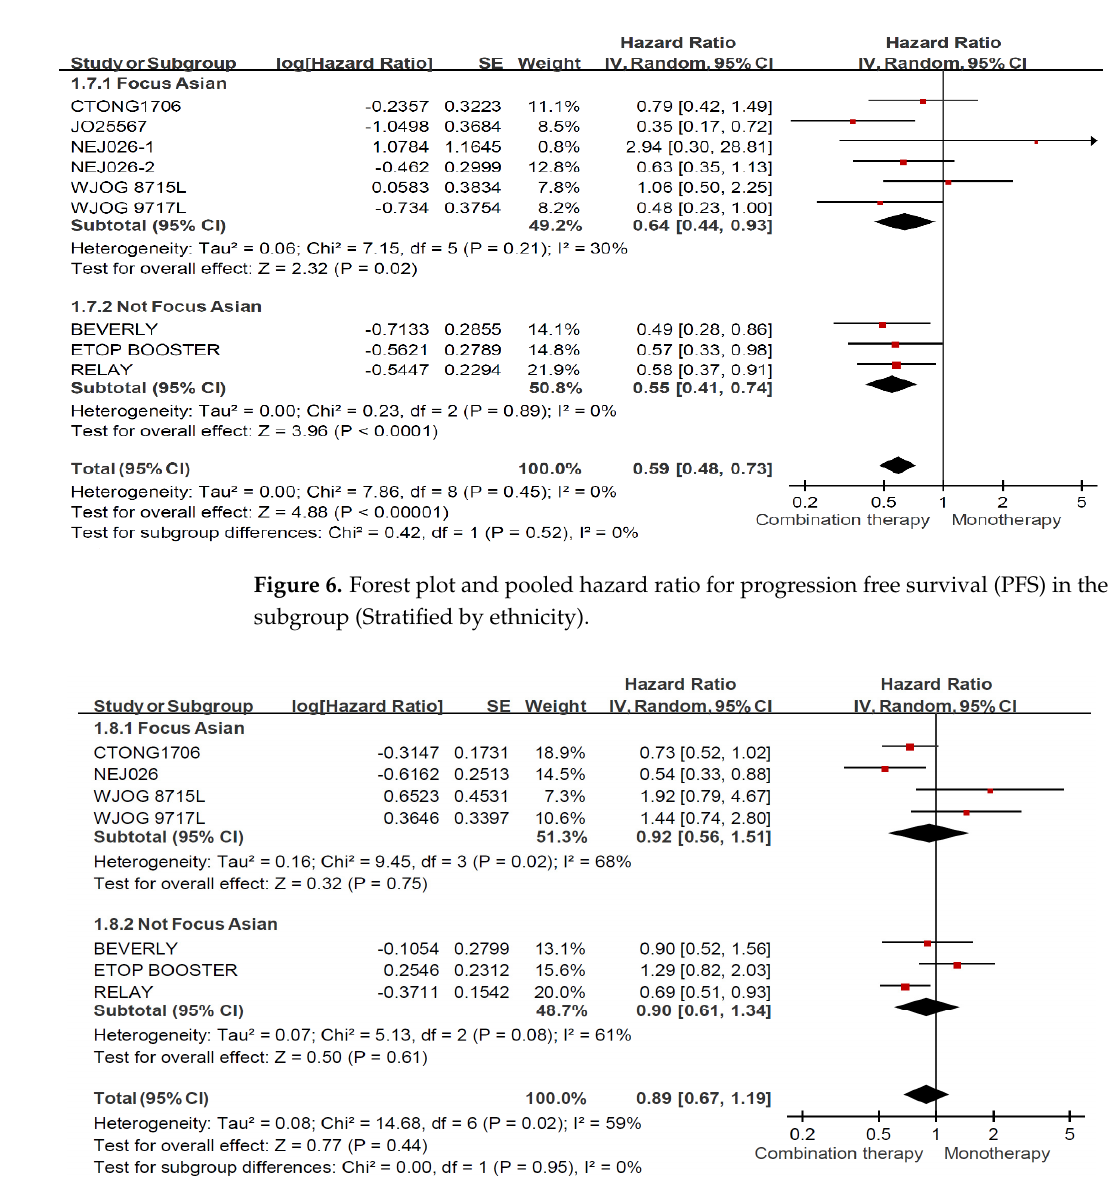
Figure 7. Forest plot and pooled hazard ratio for progression free survival (PFS) in the never smoker subgroup (Stratified by ethnicity).